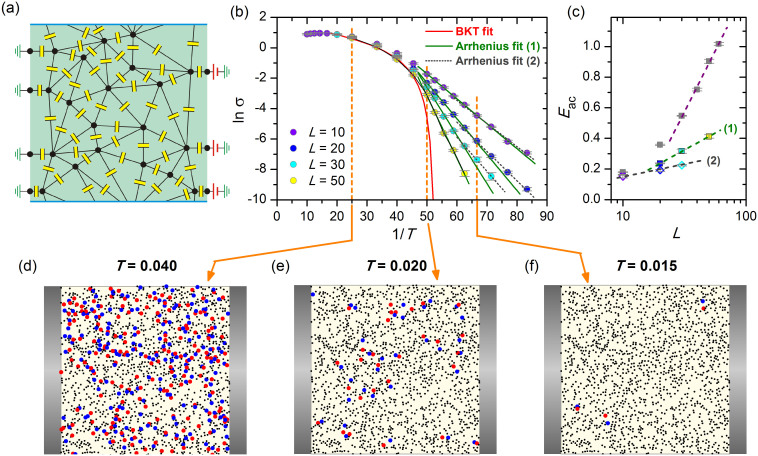
Two-dimensional random capacitor network (2DRCN).(a) A sketch of 2DRCN. The electrode connected to the left edge row of capacitors is grounded, the electrode at the right edge has potential V. (b) Logarithm of conductivity σ, shown by colored circles, as function of the inverse temperature, 1/T, for different system sizes listed in the legend and Λ → ∞. Straight solid lines are Arrhenius fits (1), σ ∝ exp(−Eac/T), in the temperature interval 0.020 > T > 0.016. The dashed lines are Arrhenius fits (2) for T < 0.016. The red curve represents the BKT behaviour given by Eq.(4) extrapolated from the data at temperatures T > 0.020. (c) Size dependence of the activation energy Eac inferred from the Arrhenius fits (1) and (2) of panel (d). The upper grey symbols replot the data from Fig. 1e for the regular network presented for comparison. (d)–(f) Snapshots of the charge distribution corresponding to three representative temperatures marked by vertical dashed lines in the panel (b). Black dots stand for neutral sites. Blue and red circles depict the sites with the excess negative and positive charges at the site, respectively.